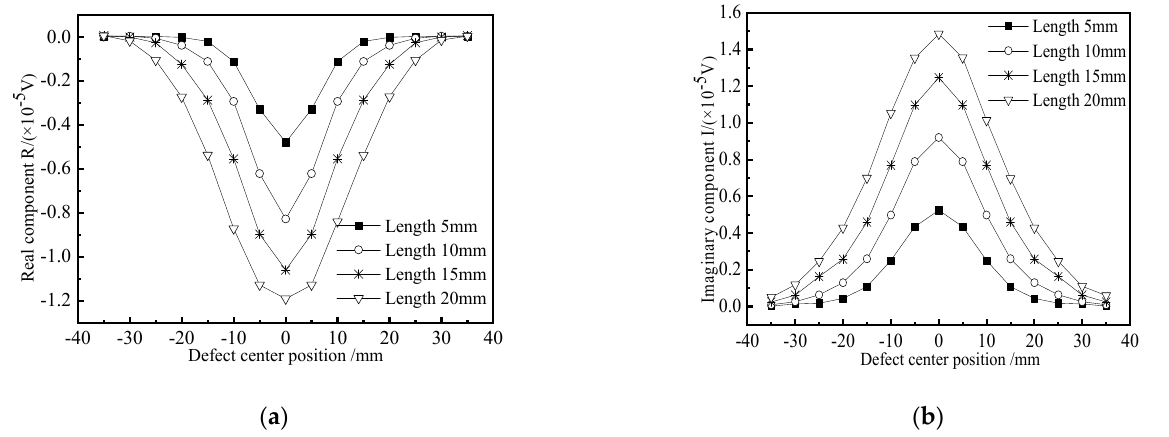
( b ) Figure 17. Crack defect detection signals at different buried depths. ( a ) Real component; ( b ) Imagi- nary component. 5. Test Verification